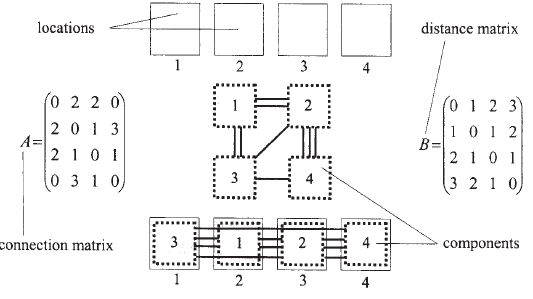
Figure 1. Graphical interpretation of the quadratic assignment problem. For given matrices A and B the permutation corresponding to optimal assignment is as follows:(2,3,1,4). The connection length that corresponds this assignment is equal to